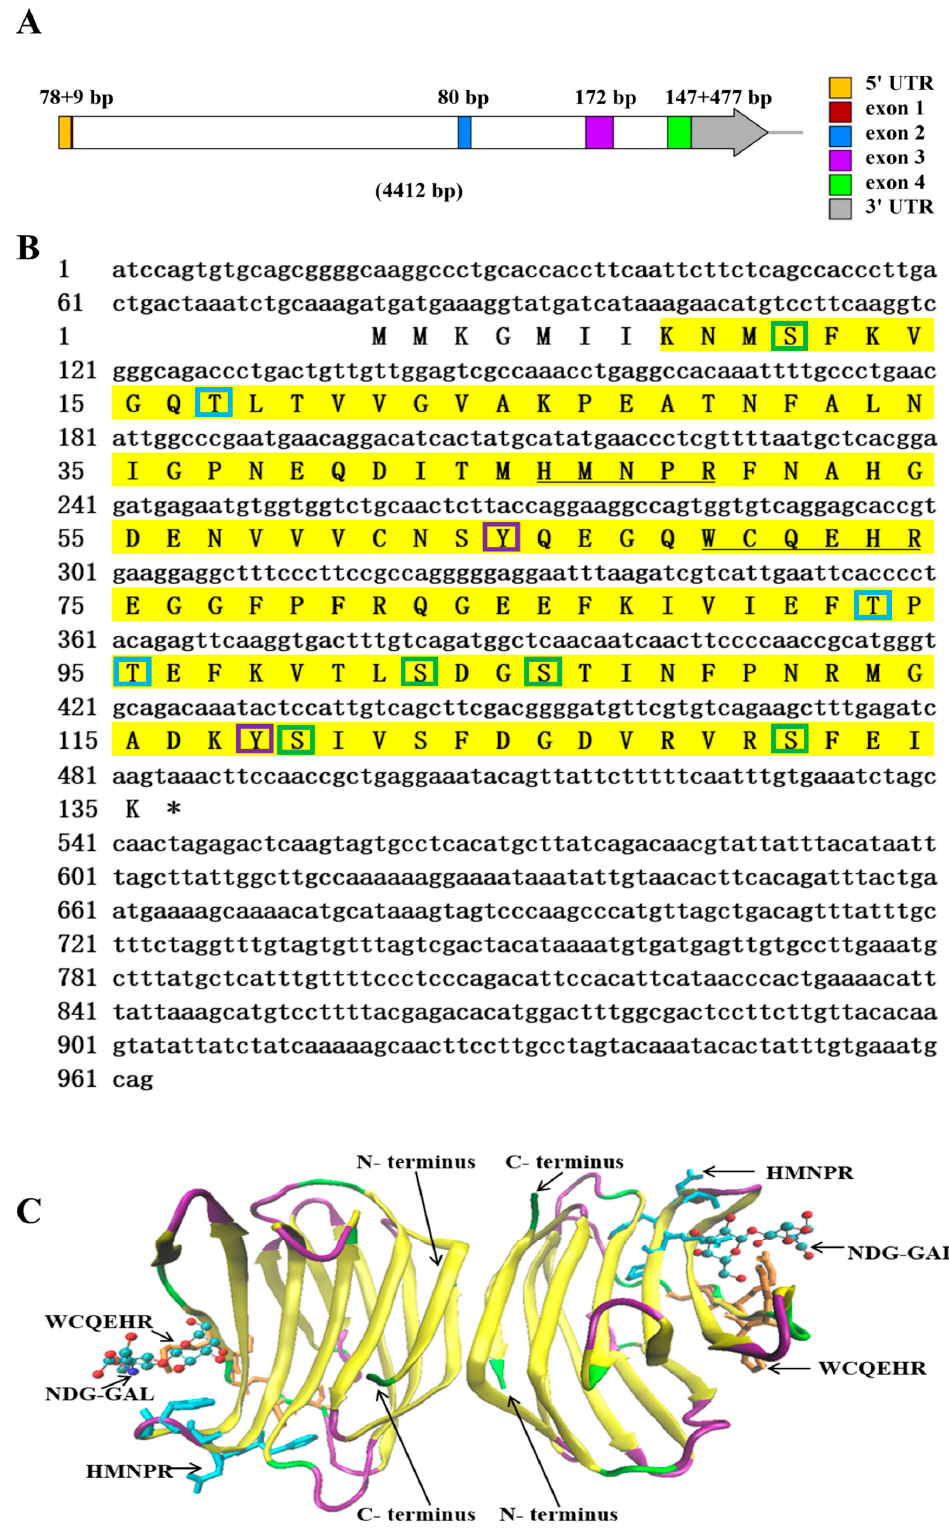
Figure 1. The sequence and structure analysis of NaGal-1 . ( A ) The diagram of NaGal-1 gene structure in N. albiflora . The squares in different color within the arrow area represent the different exons